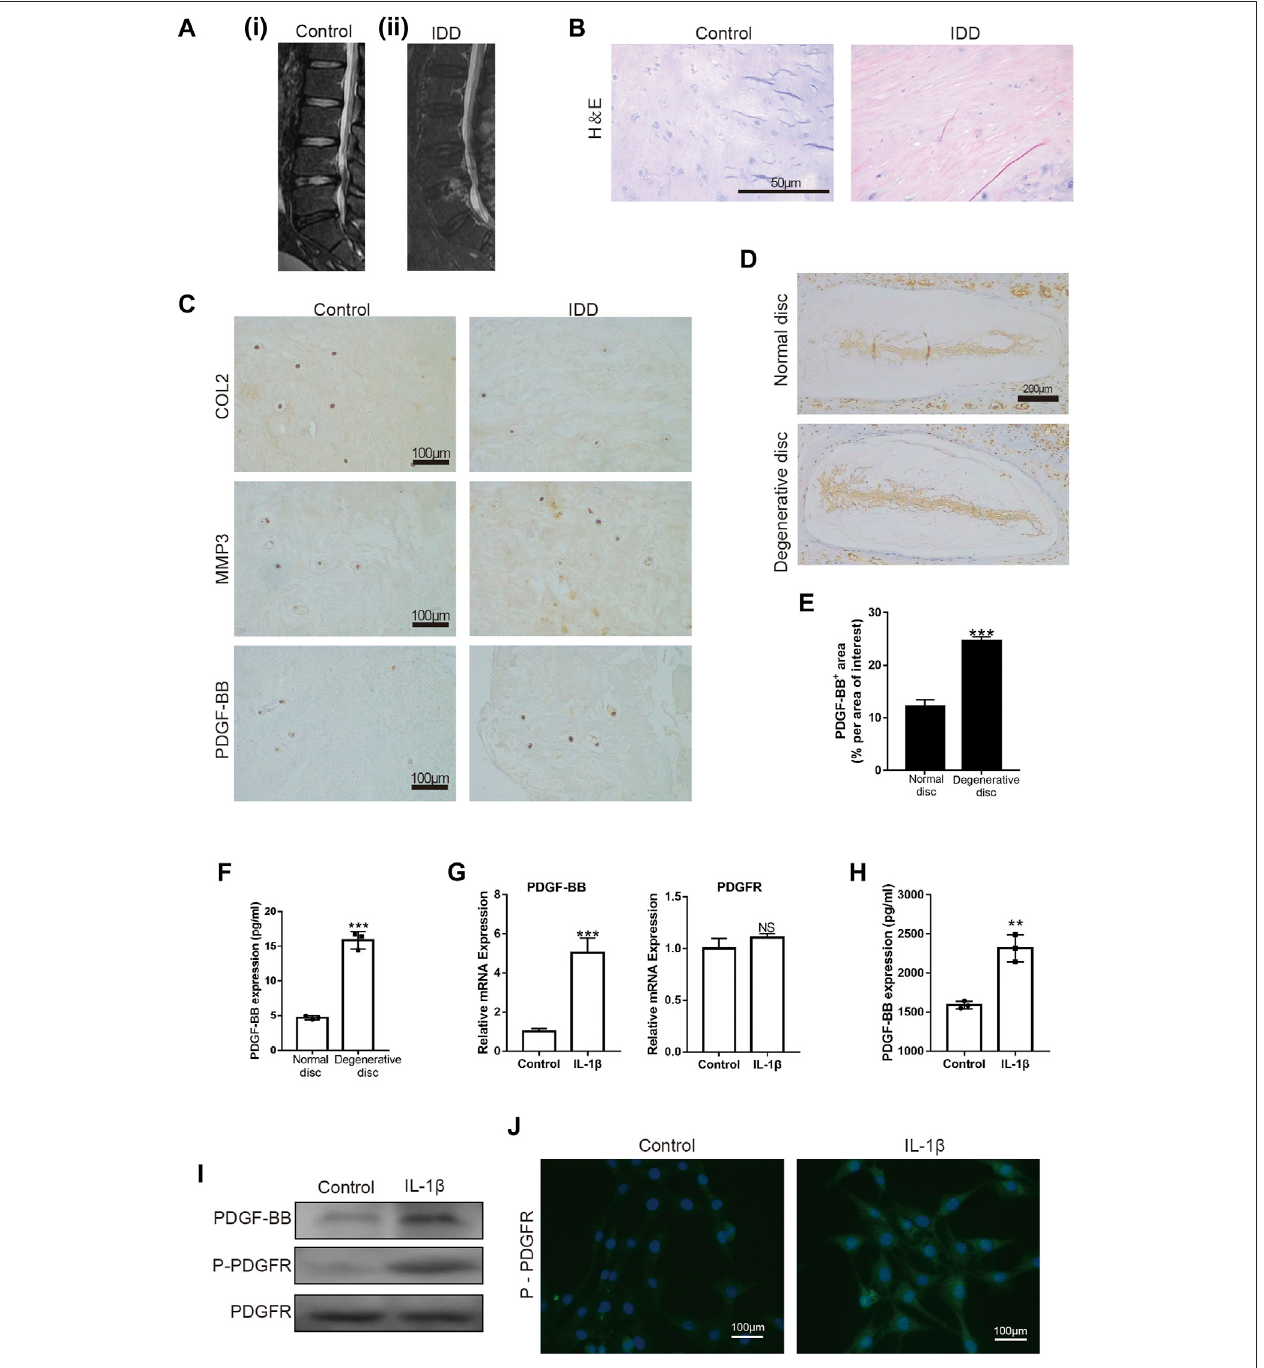
FIGURE1| PDGF-BBisexpressedinnucleuspulposustissueandNPcells. (A) MRIofintervertebraldiscs; (i) patientwithL4vertebralfractures; (ii) patientwithL4/ 5discherniation. (B) Hematoxylinandeosinstainingofnucleuspulposustissueinpatientswithvertebralbodyfractureandlumbardischerniation.Scalebar,50 μ m. (C) Immunohistochemical images of COL2, MMP3 and PDGF-BB of human nucleus pulposus tissue. Scale bar, 100 μ m. (D,E) Immunohistochemical images of PDGF-BB ofmouseintervertebraldisc.AveragepercentageofpositivestainingareaofPDGF-BB.Scalebar,200 μ m. (F) ELISAshowstheexpression ofPDGF-BB inmouse intervertebraldisc. (G – I) QuantitativePCR,ELISAandWesternblotwereusedtodetectPDGF-BBofNPcells. (J) Immuno fl uorescenceimagesofP-PDGFRofNPcells. Scale bar, 100 μ m. All NP cells were treated with or without IL-1 β (10 ng/ml) for 48 h. Data are presented as the mean ± SD. Signi fi cant differences between groups are indicated as **** p < 0.0001, *** p < 0.001, ** p < 0.01.